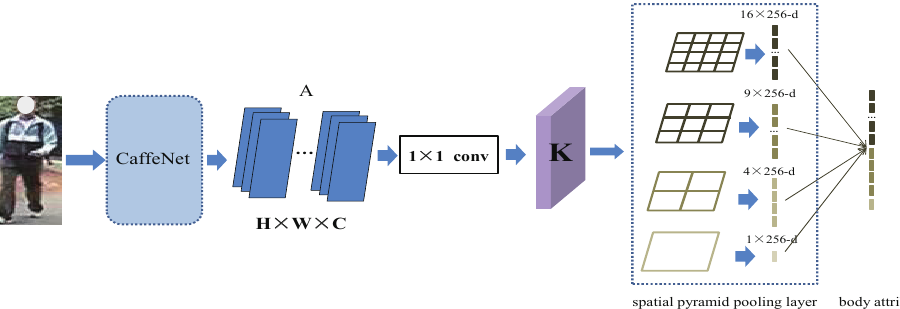
Figure 4. The body attribute network consists of a 1 × 1 convolution operation and a spatial pyramid pooling layer for the personal body attribute